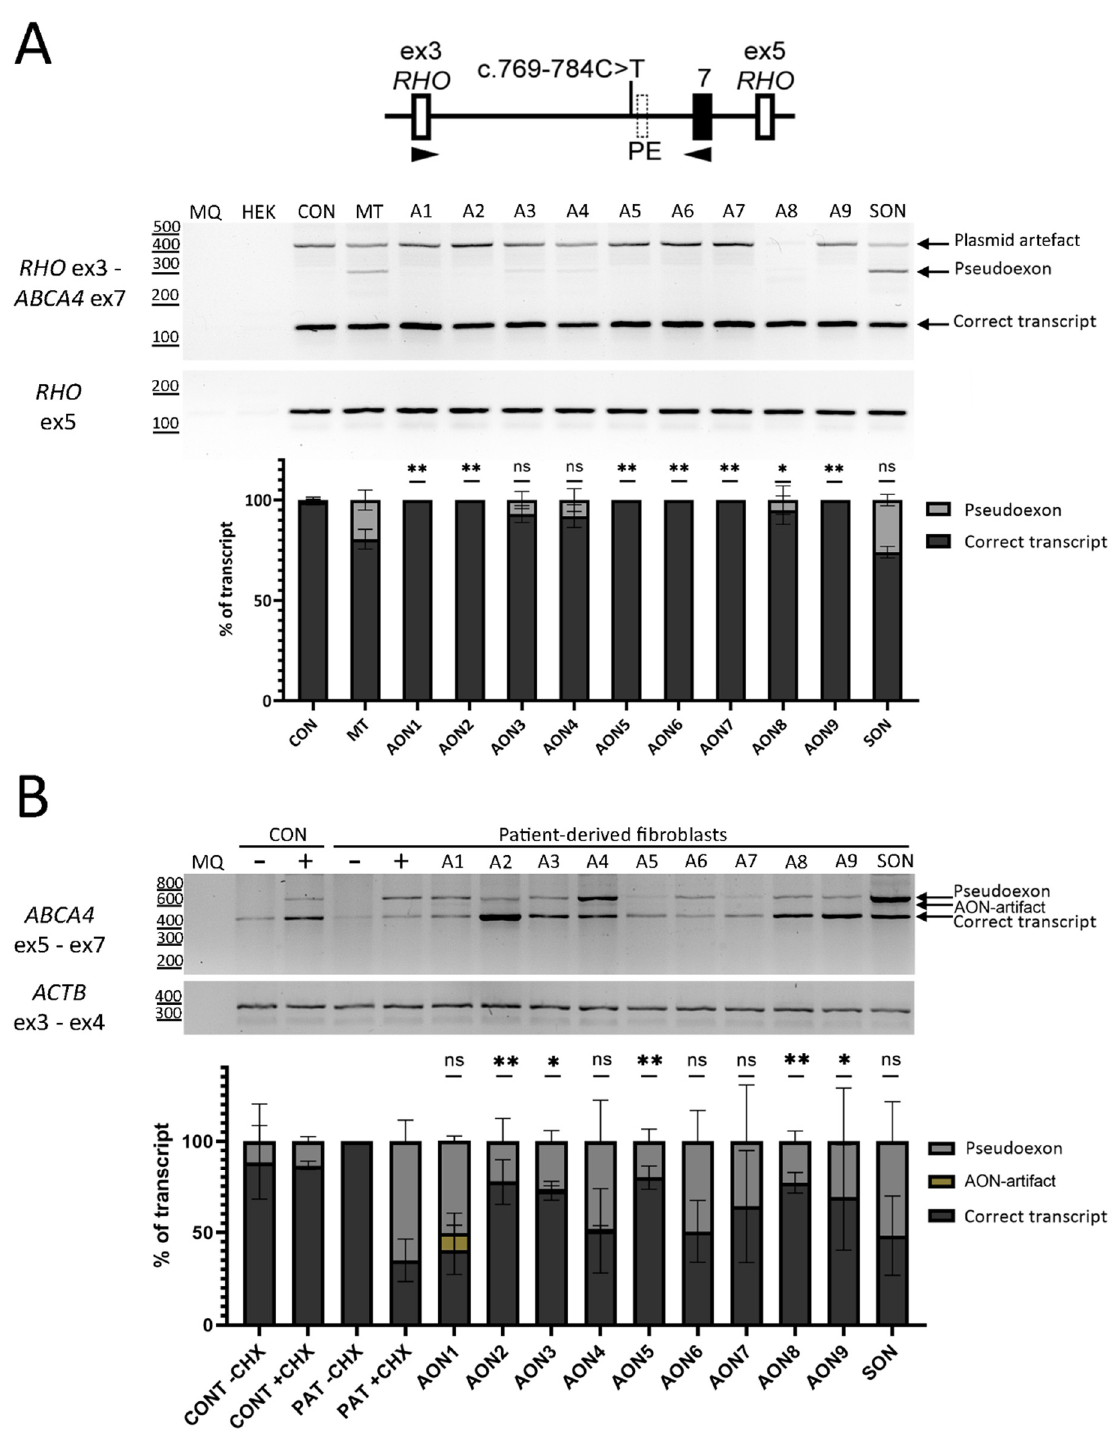
Figure 2. AON-based rescue for the deep-intronic c.769-784C>T variant in two cellular models. Analysis of splicing correction by RT-PCR upon AON delivery. ( A ) The midigene carrying the c.769-784C>T variant and control midigene were transfected in HEK293T except for the endogenous HEK293T expression control (HEK). The nine AONs and SON were co-transfected to cells expressing the midigene carrying c.769-784C>T variant and were labelled from A1 to SON. The AON-not transfected wells identified as control (CON) and mutant (MT) were used as a reference for splice correction. The genomic region of the used midigene is represented on top of the RT-PCR result. The graph below represents the semi-quantification of the resulting RT-PCR products, showing the percentage of correct and PE inclusion transcript. Statistically significant PE exclusion was achieved